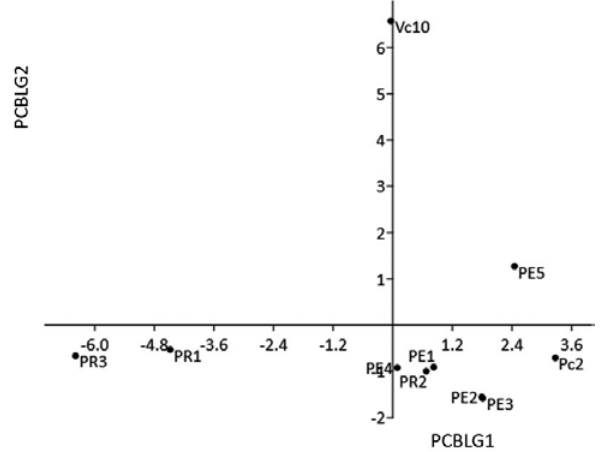
Figure 6. Principal Component Analysis of carbon utilisation pro- files obtained through Biolog FF MicroPlates for Pochonia chlamydo- sporia isolates (PE1, PE2, PE3, PE4, PE5, PR1, PR2, PR3, Pc2 and Vc10, refer to Table 1 for isolate information). PCBLG1 eigen value 9.470; PCBLG2 eigen value